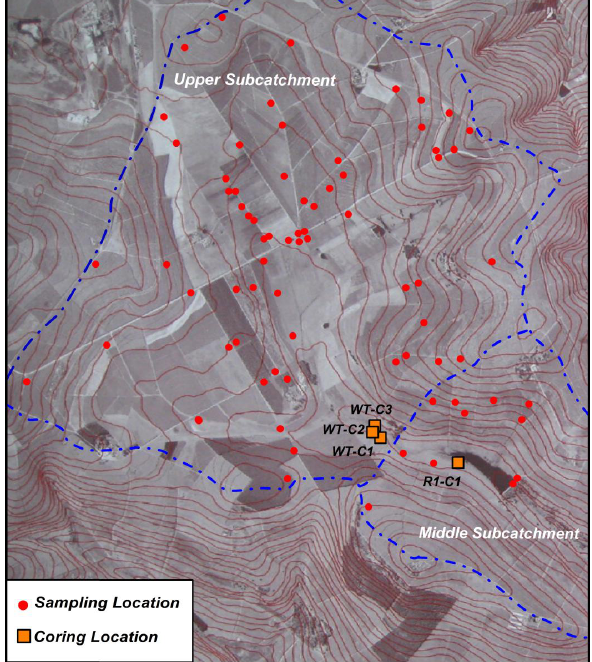
Fig. 4. Sampling and coring locations within the Mkabela